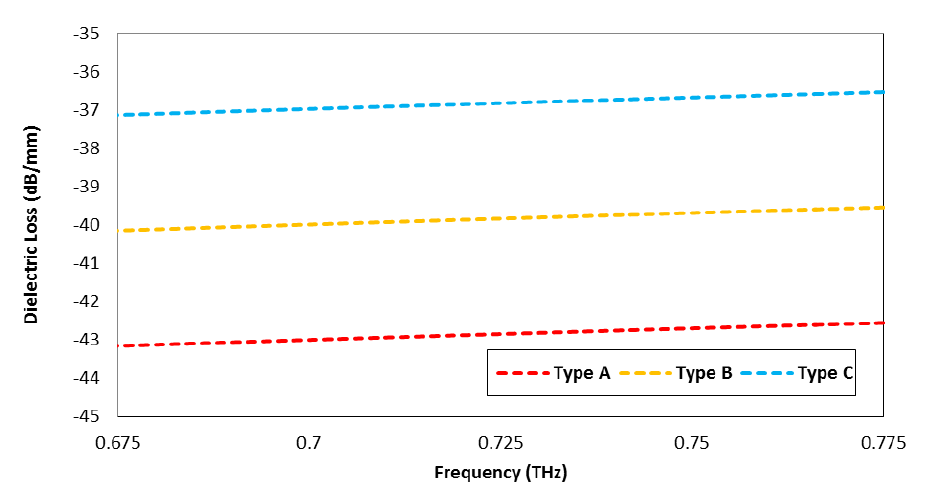
Figure 12. The dielectric loss per millimeter of Type A, Type B, and Type C antennas. The 2D polar plots and 3D radiation patterns of Type A antenna, Type B antenna, and Type C antenna are shown in Figures 13 and 14, respectively. The simulation results show that the dual-band type A antenna directs the THz signals at 5.38 ◦ and 39.0 ◦ with the half power beam widths (HPBW) of 54.3 ◦ and 64.5 ◦ , the side lobe of − 2.2 and − 1.8 dB, while operating at frequencies of 0.708 and 0.75225 THz with main lobe magnitudes of 5.51 and 6.25 dB and a radiation efficiency of 91.66 and 90.35%, respectively. Similarly, the Type B antenna array directs the THz signals at 56 ◦ and − 8 ◦ with the half-power beam widths (HPBW) of 43.1 ◦ and 68 ◦ , with side lobes of − 4.5 and − 2.7 dB while operating at frequencies of 0.689 and 0.758 THz with main lobe magnitudes of 9.95 and 7.75 dB and radiation efficiencies of 96.09 and 95.45%, respectively. Additionally, the Type C antenna array directs the THz signals at 58 ◦ and − 25 ◦ with the half-power beam width (HPBW) of 49.8 ◦ and 27.8 ◦ , with side lobes of − 2.2 and − 2.7 dB while operating at frequencies of 0.714 and 0.7412 THz with main lobe magnitudes of 12.5 and 11.23 dB and radiation efficiencies of 99.76 and 96.6%, respectively. From these values, it is concluded that as the number of transmitting elements increases in the array, the dual-band THz antenna array becomes more directive.The THz antenna is reasonably matched with feed lines, which is why the side lobes are negligible and the array antennas are more than 90 %